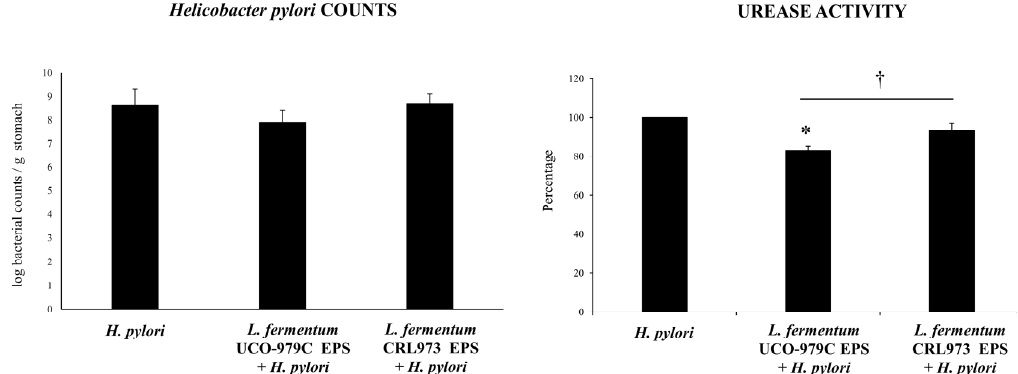
Figure 10. E ff ect of L. fermentum UCO-979C or L. fermentum CRL973 EPS on gastric colonization of H. pylori SS1. L. fermentum UCO-979C or L. fermentum CRL973 EPS were administered to di ff erent groups of mice for two consecutive days at a dose of 10 8 100 µ g / mL / mouse / day, then mice were challenged with H. pylori SS1. Two days post-infection, mice were euthanized, H. pylori counts (Log CFU / g of tissue) and Urease activity (% percentage) were determined in gastric explants. Mice infected with H. pylori were used as controls. Results are expressed as mean ± standard deviation. Significant di ff erences when compared to the control group: * ( p < 0.05). Significant di ff erences when compared to the indicated group: † ( p < 0.05).